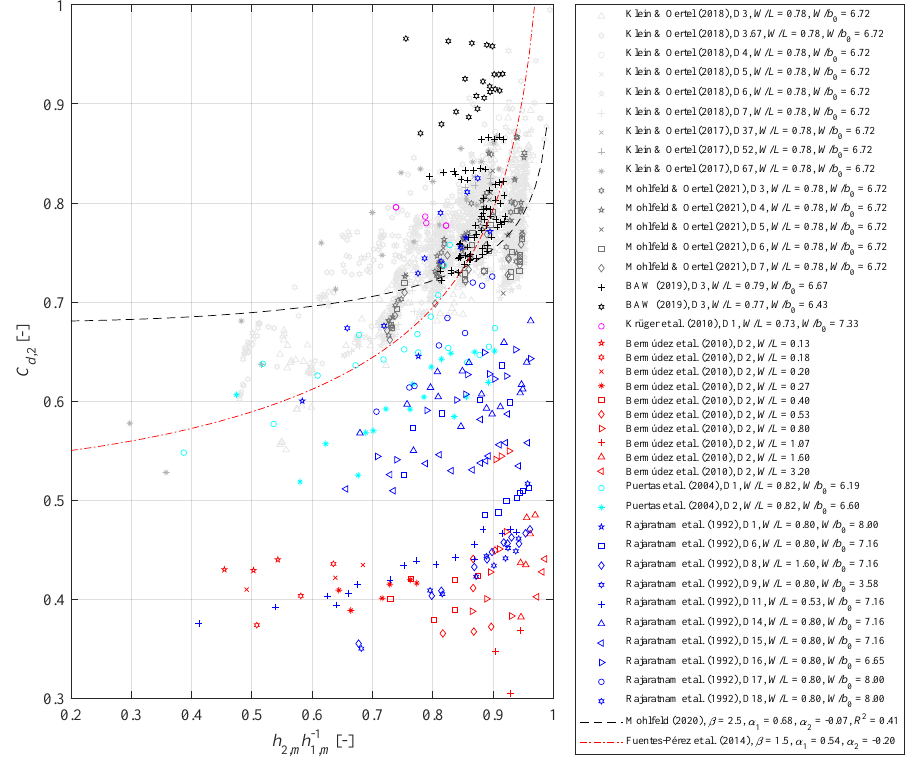
Figure 6. Discharge coefficients and existing fitting equations according to Equation (3) based on Torricelli (Equation (8))